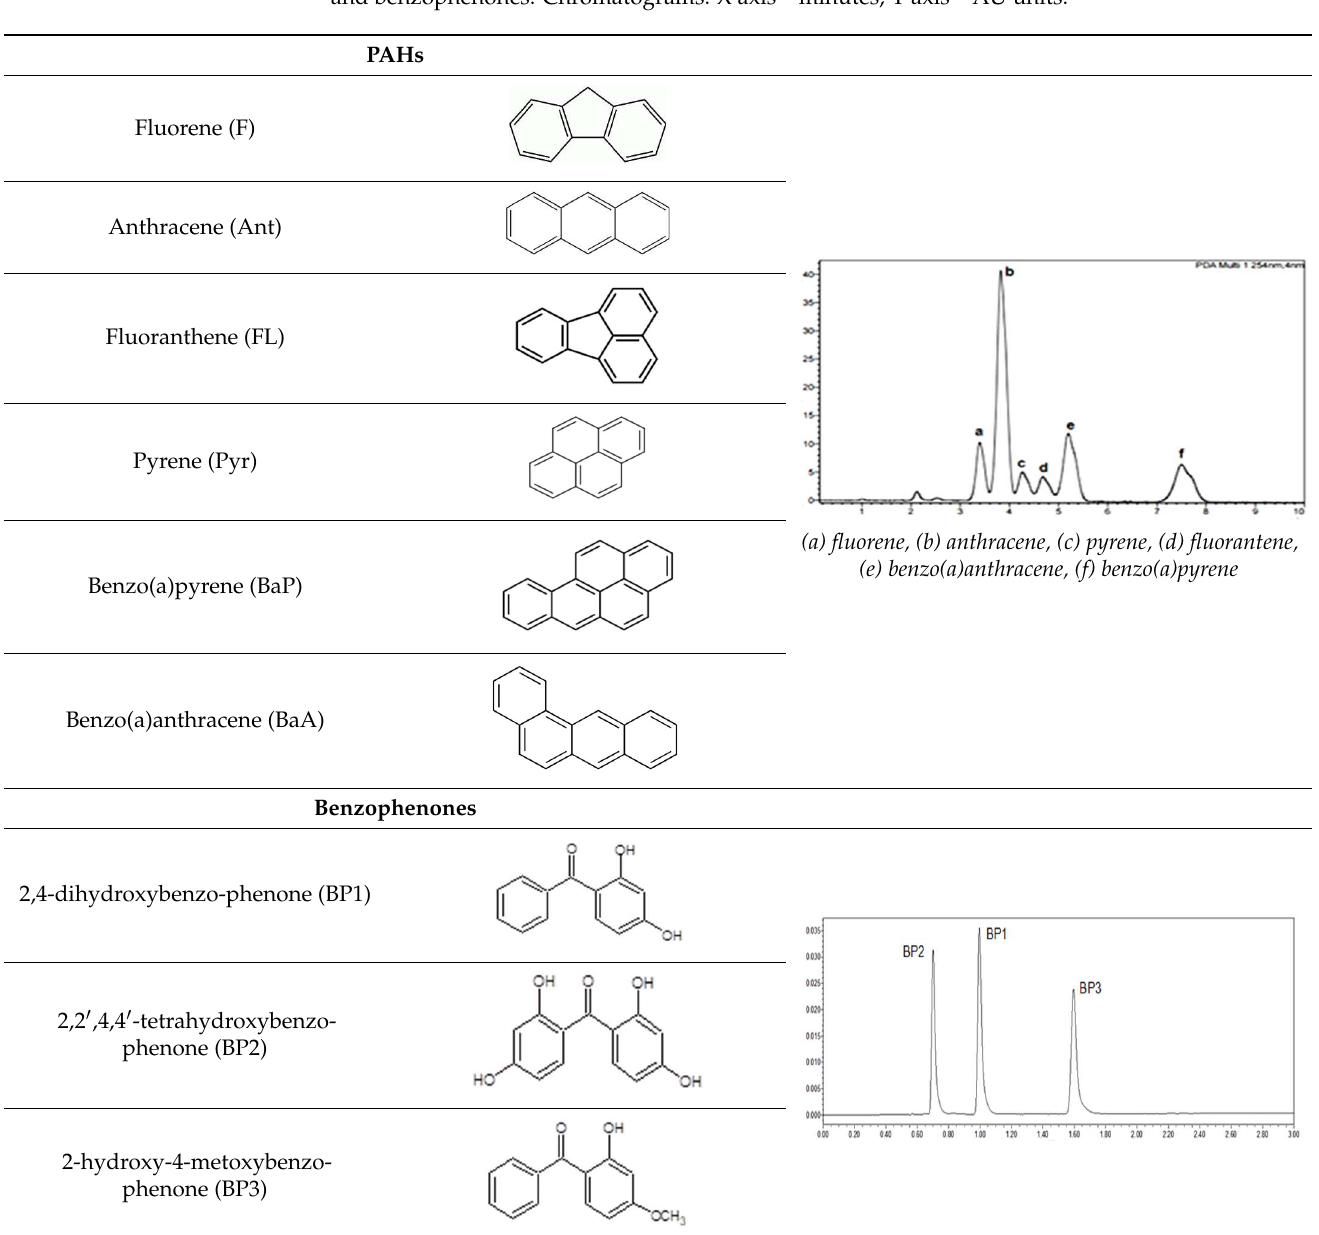
Figure 1. Scheme of synthesis of MNPs and their paramagnetic properties.